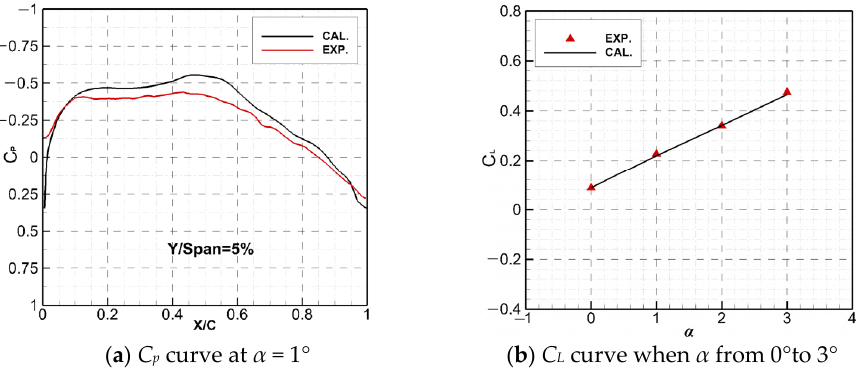
Figure 7. Comparison of C L and C p curve between the experiment and calculation results.